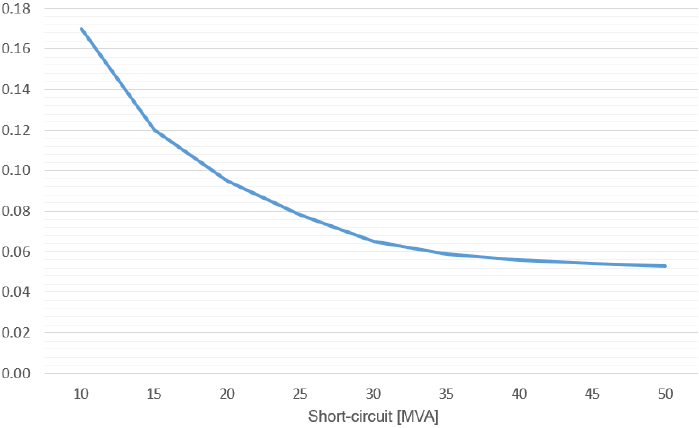
Figure 3. Dependence of the voltage fluctuation factor on the short-circuit power at the point of connection.